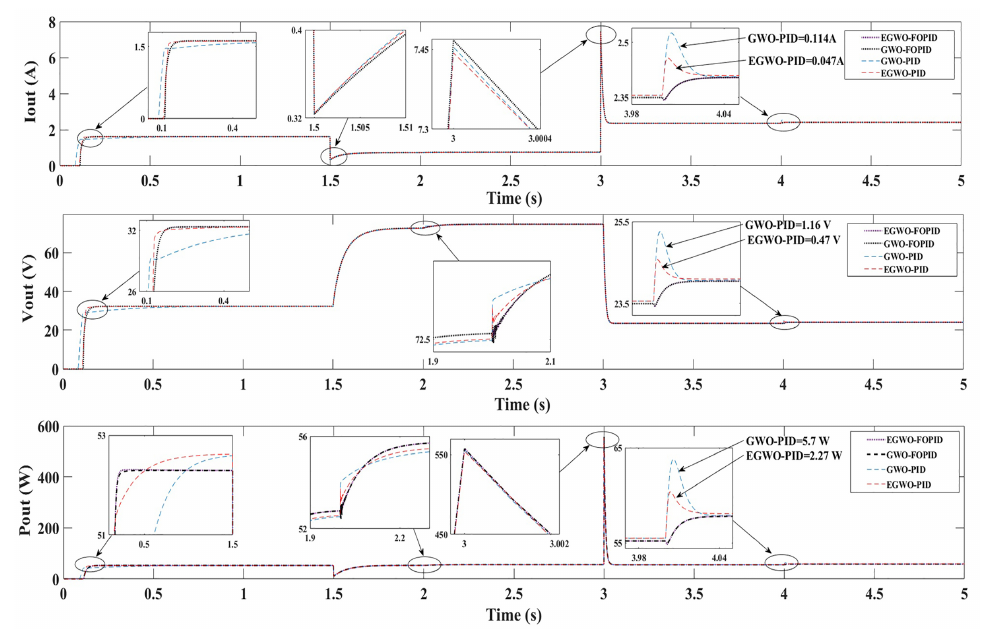
Figure 12. Boost converter output